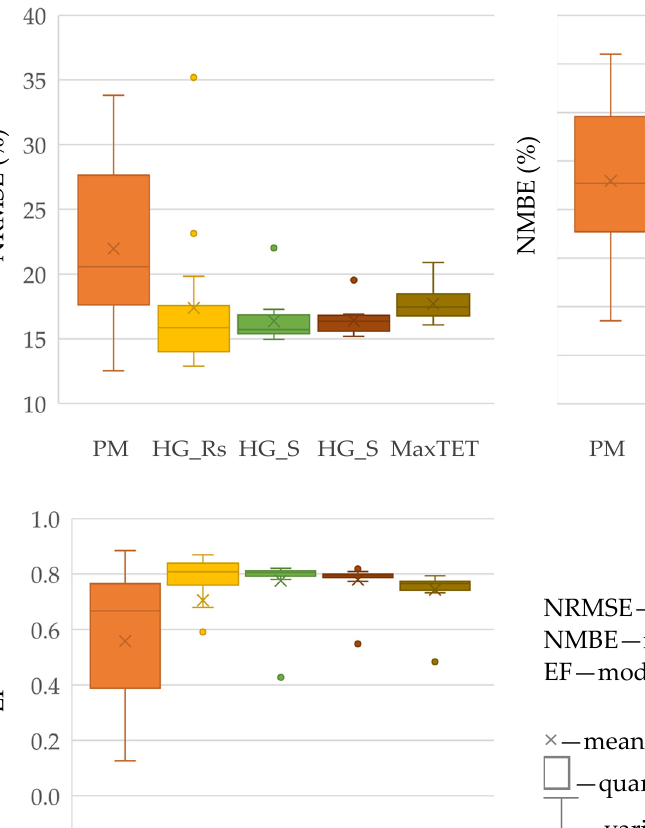
7 of 14 Table 3. Distribution of the statistical accuracy indicators when comparing daily ETo estimated from raw (non-bias- corrected) NASA POWER data with ETo-PM estimated from observed weather data relative to all locations. Accuracy Indicator